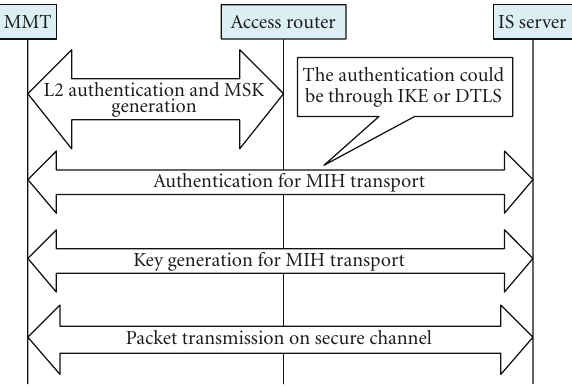
Figure 11: IPSec/DTLS key generations at IS server. Figure 12: MIH transport key generation at IS server using L2